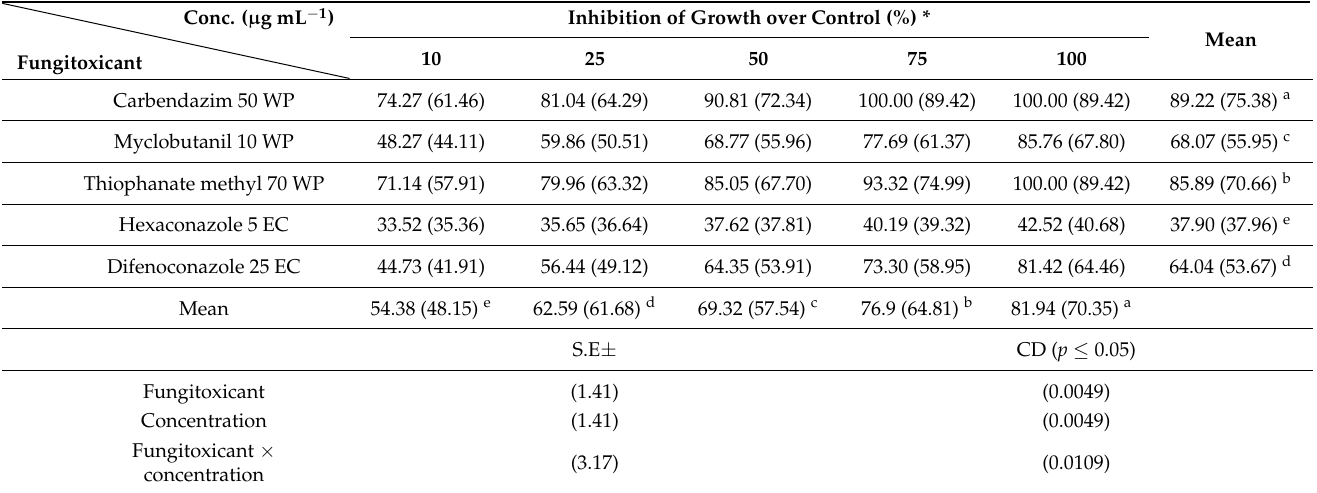
Table 7. Effect of systemic fungitoxicants under in vitro conditions against T. harzianum